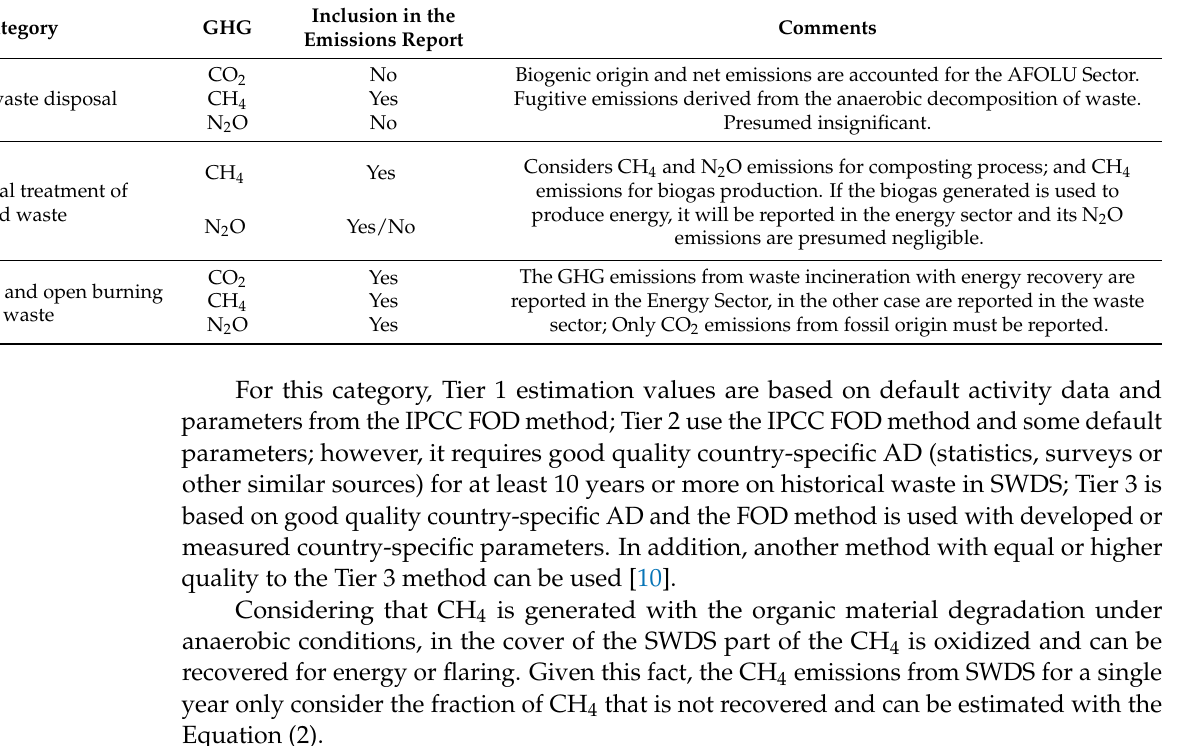
Table 1. GHG source and emissions categories related to solid waste included in the IPCC 2006 guidelines [11]. Inclusion in the Category GHG Emissions Report